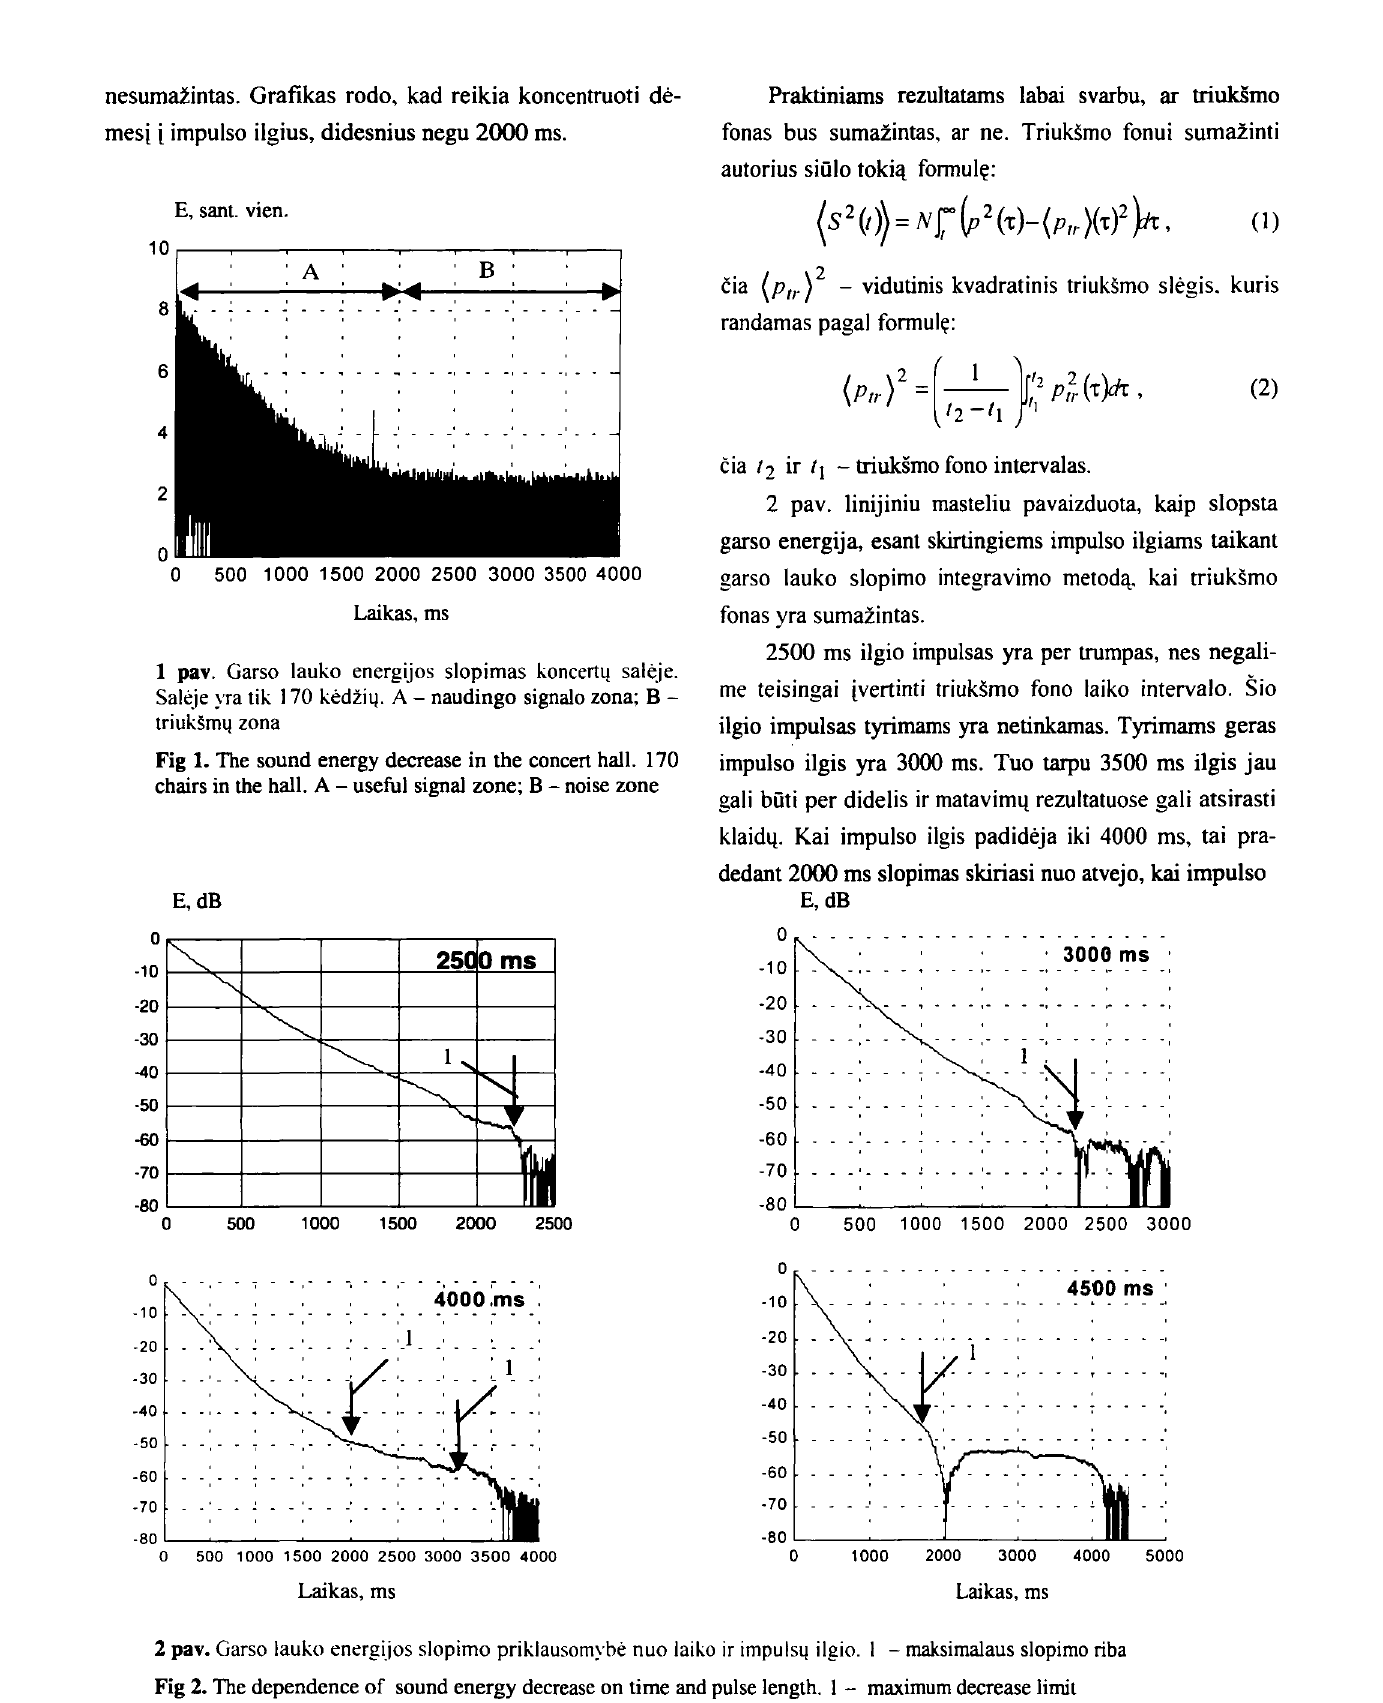
Fig 2. The dependence of sound energy decrease on time and pulse length. I - maximum decrease